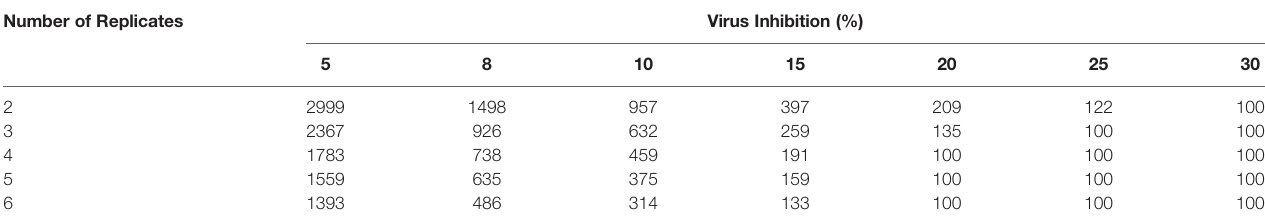
The minimum allowed percentage of HIV infection was 0.5%.